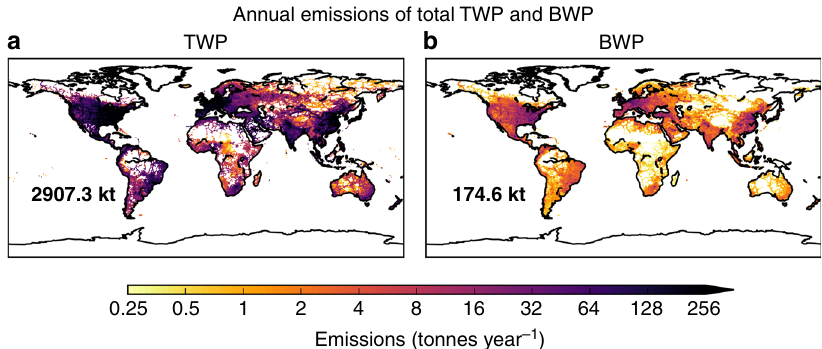
Fig. 1 Annual gridded emissions of road microplastics. Global annual emissions of total road microplastics (tyre wear particles, TWPs, in a , and brake wear particles, BWPs, in b ). TWP emissions are the average of the calculated emissions using the CO 2 ratio method and the GAINS model. Bold numbers at the left bottom of each panel represent the annual emissions of total TWPs and BWPs from road vehicles for 2014, which were estimated to be 2907 and 174.6 kt,